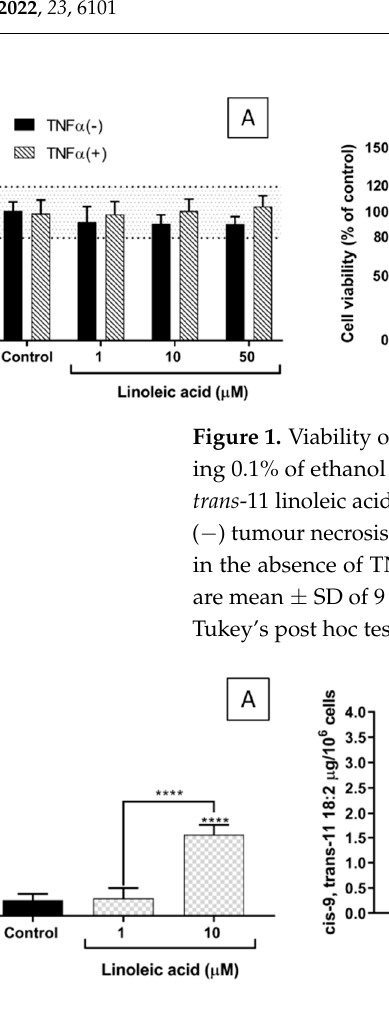
Figure 2. Incorporation of fatty acids into EA.hy926 cells incubated for 48 h with DMEM containing 0.1% of ethanol (Control) or different concentrations (1 or 10 μ M) of linoleic acid ( A ), cis -9, trans -11 linoleic acid ( B ), trans-10, cis-12 linoleic acid ( C ). Bars are mean ± SD of 6–9 samples from 3 experiments. Data were analysed using one-way ANOVA with Tukey’s post hoc test and represent the total amount of each fatty acid in the cells across all lipids present. * p < 0.05; ** p < 0.01; **** p < 0.0001; where asterisks are shown immediately above a bar they refer to dfference from Control and where asterisks are shown above a horizontal line they refer to differences between the two groups indicated by that line.